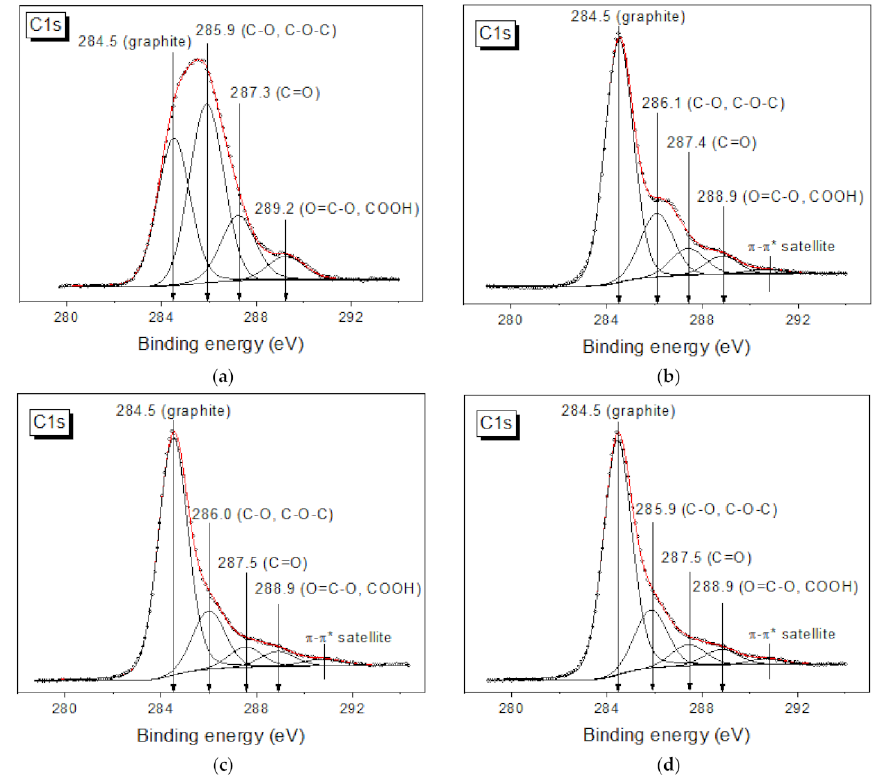
Figure 4. XPS spectra of ( a ) GO; ( b ) MOG; ( c ) rGO; ( d ) rMOG. Table 2. Contribution of carbon states to the total C1s spectrum